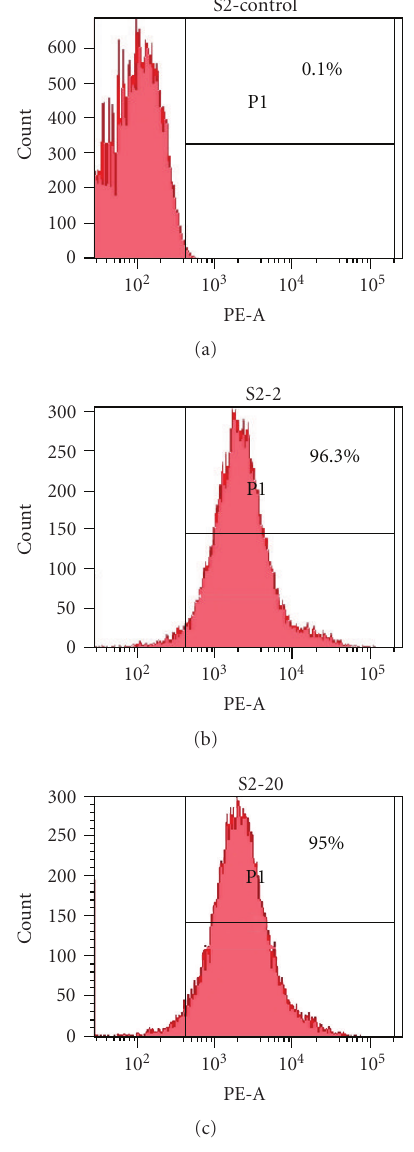
Figure 7: FACS analysis of dsRED expression in the di ff erent passages of the SP Δ asd mutant (pYA3334-dsRED). S2-control: control for the SP Δ asd mutant (pYA3334); S2-2: The 2nd passage of the SP Δ asd mutant (pYA3334-dsRED); S2-20: The 20th passage of the SP Δ asd mutant